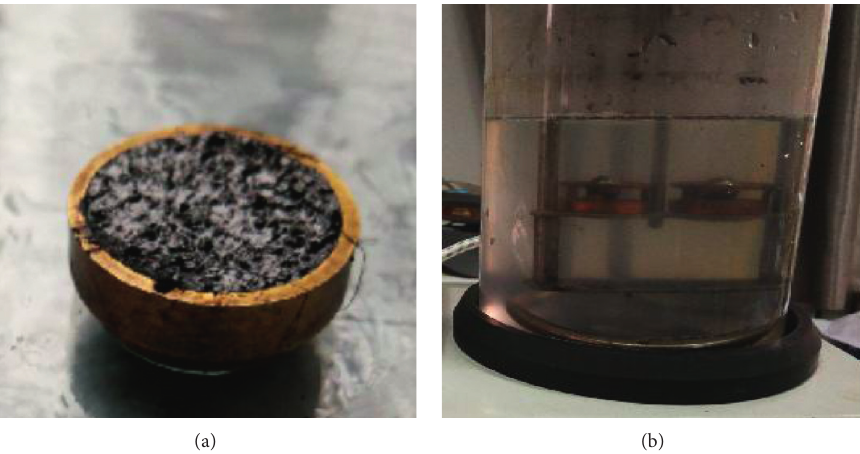
Figure 2: Softening point test of high modulus asphalt: (a) asphalt test mold of softening point; (b) softening point test instrument.